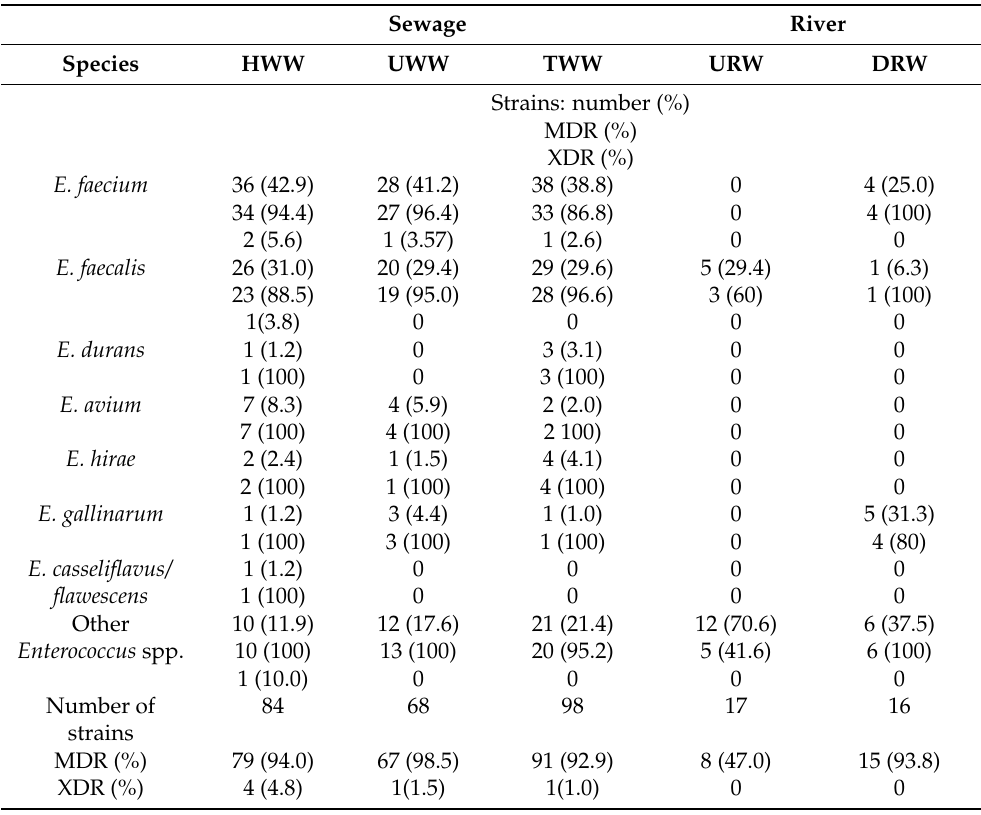
Table 2. Number and percentage of multidrug-resistant (MDR) and extensively drug-resistant (XDR) enterococci in wastewater and river